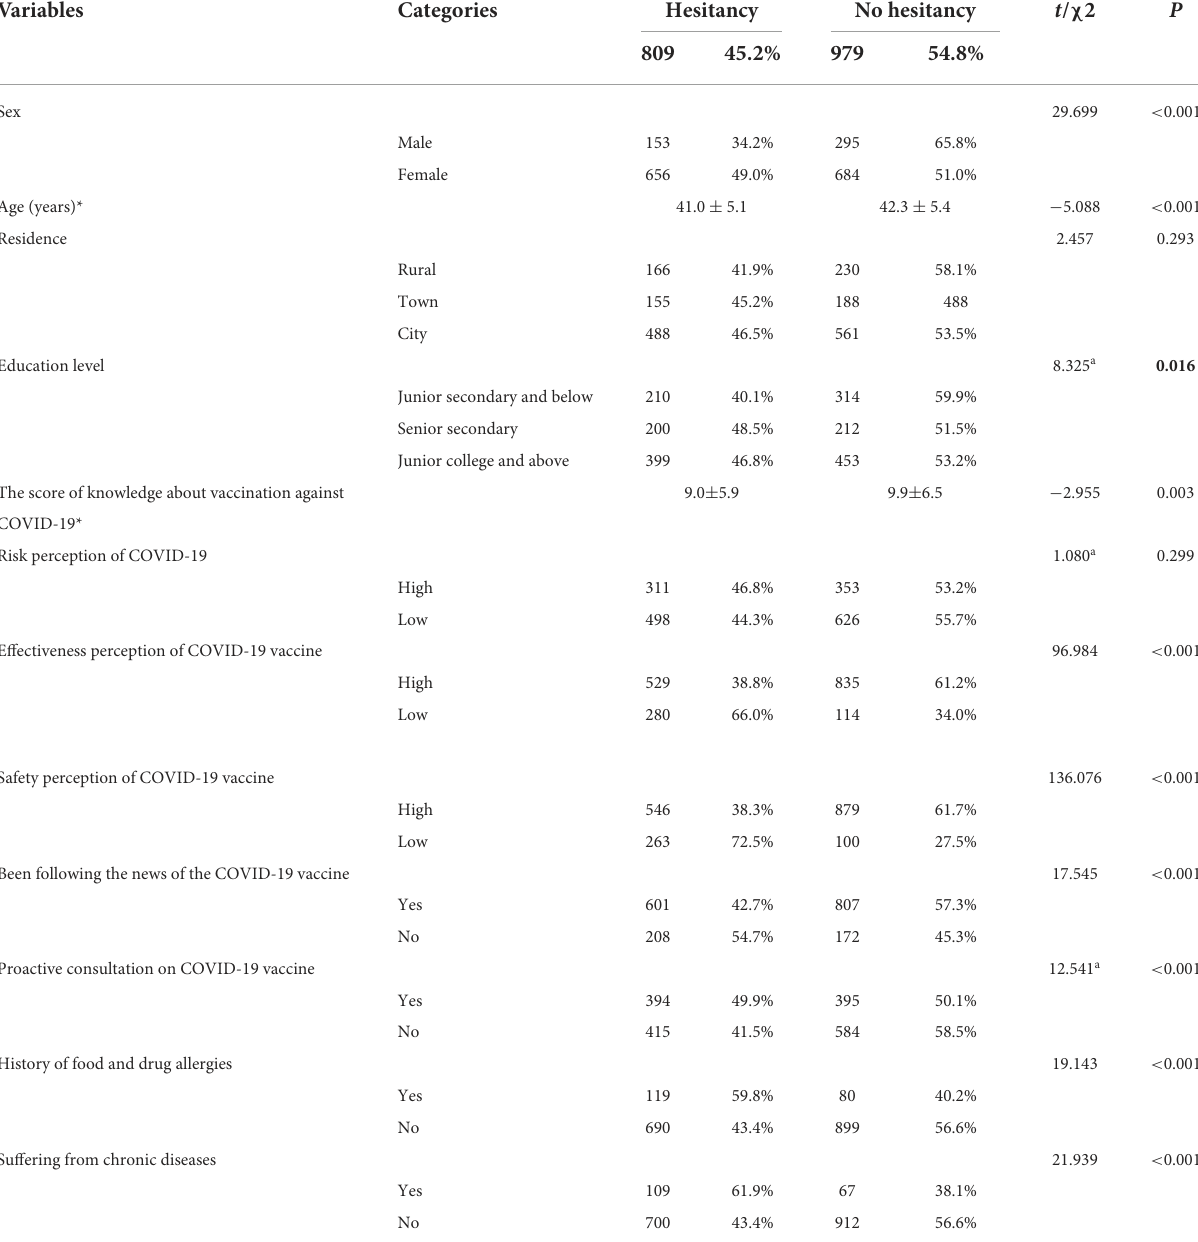
TABLE 2 Univariate analysis of factors associated with populations’ COVID-19 vaccine hesitancy ( n =